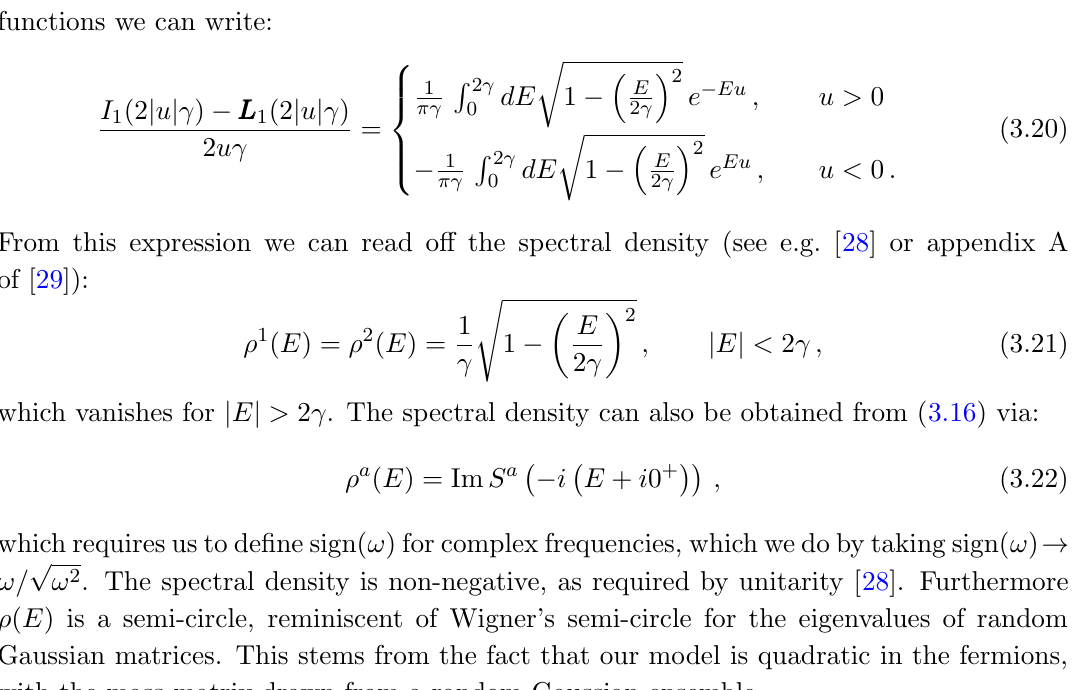
( u ) = 1 =(cid:25)(cid:13)u low